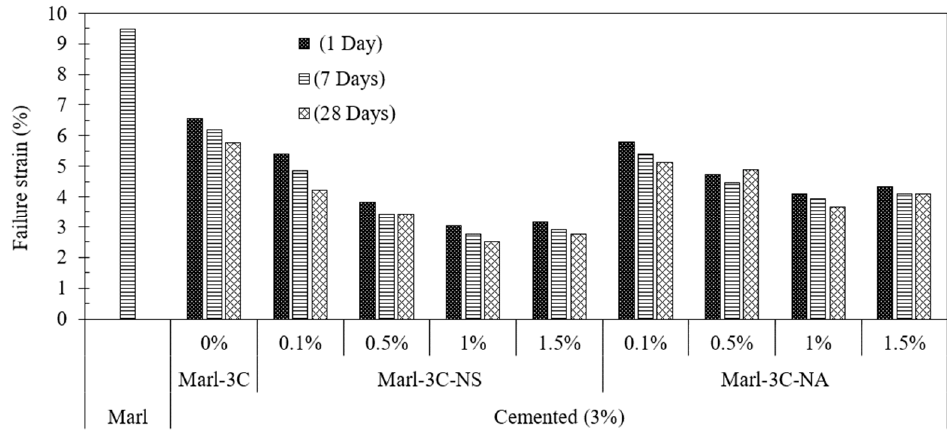
Figure 5. Axial failure strain of stabilized marl.